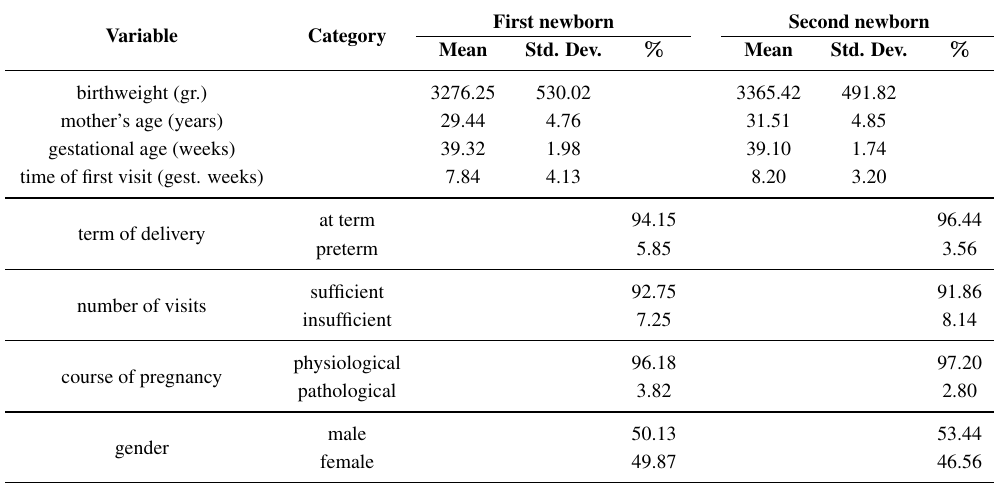
Table 1. Distribution of variables for first and second newborns: mean and standard deviation for quantitative variables and percentage values for categorical variables.